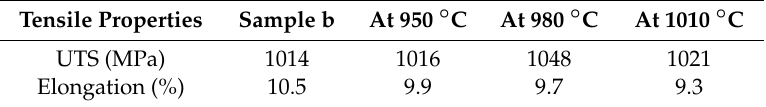
Table 5 . Tensile properties of sample b and annealed sample at different temperature. Table 5. Tensile properties of sample b and annealed sample at different